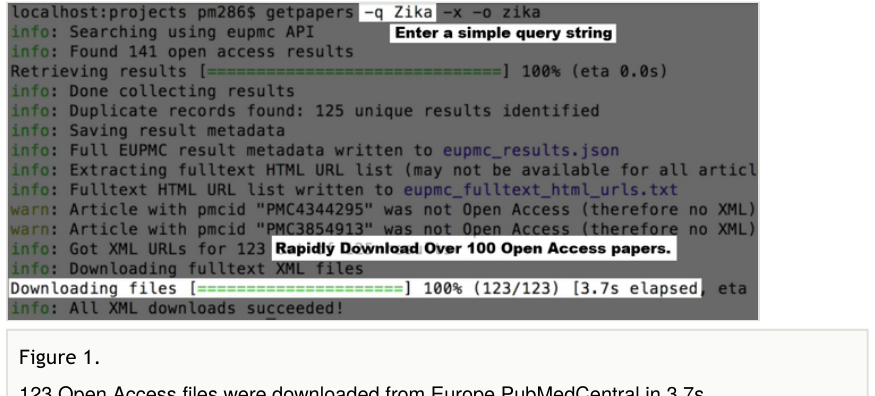
123 Open Access fi les were downloaded from Europe PubMedCentral in 3.7s.